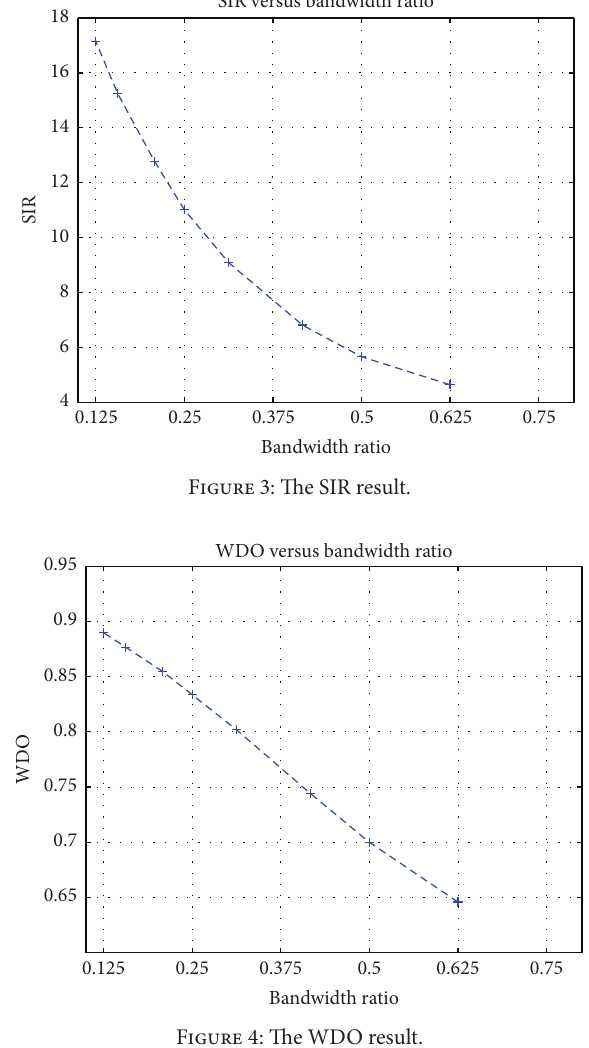
Figure 4: The WDO